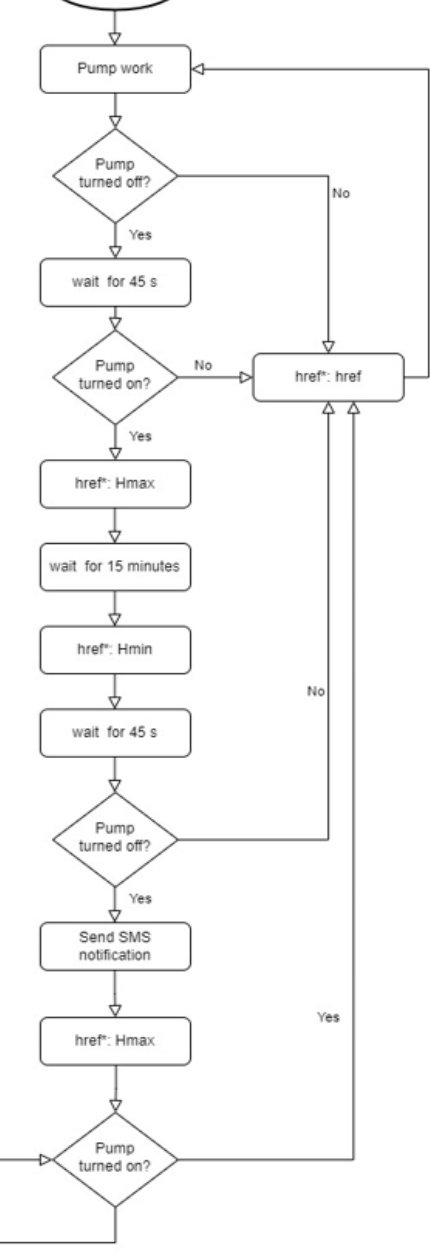
Figure 26. The algorithm for the tolerant control in the irregular PS operating modes.